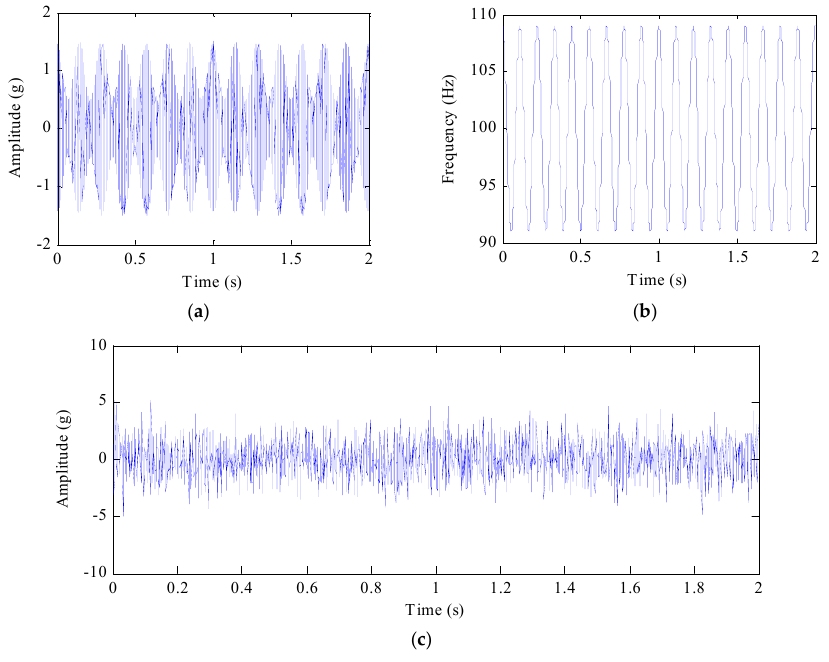
Figure 1. The simulated signal. ( a ) the signal x ( t ) = (1 + 0.5cos(14 π t )) cos(200 π t + 1.5sin(18 π t )) for 0 < t